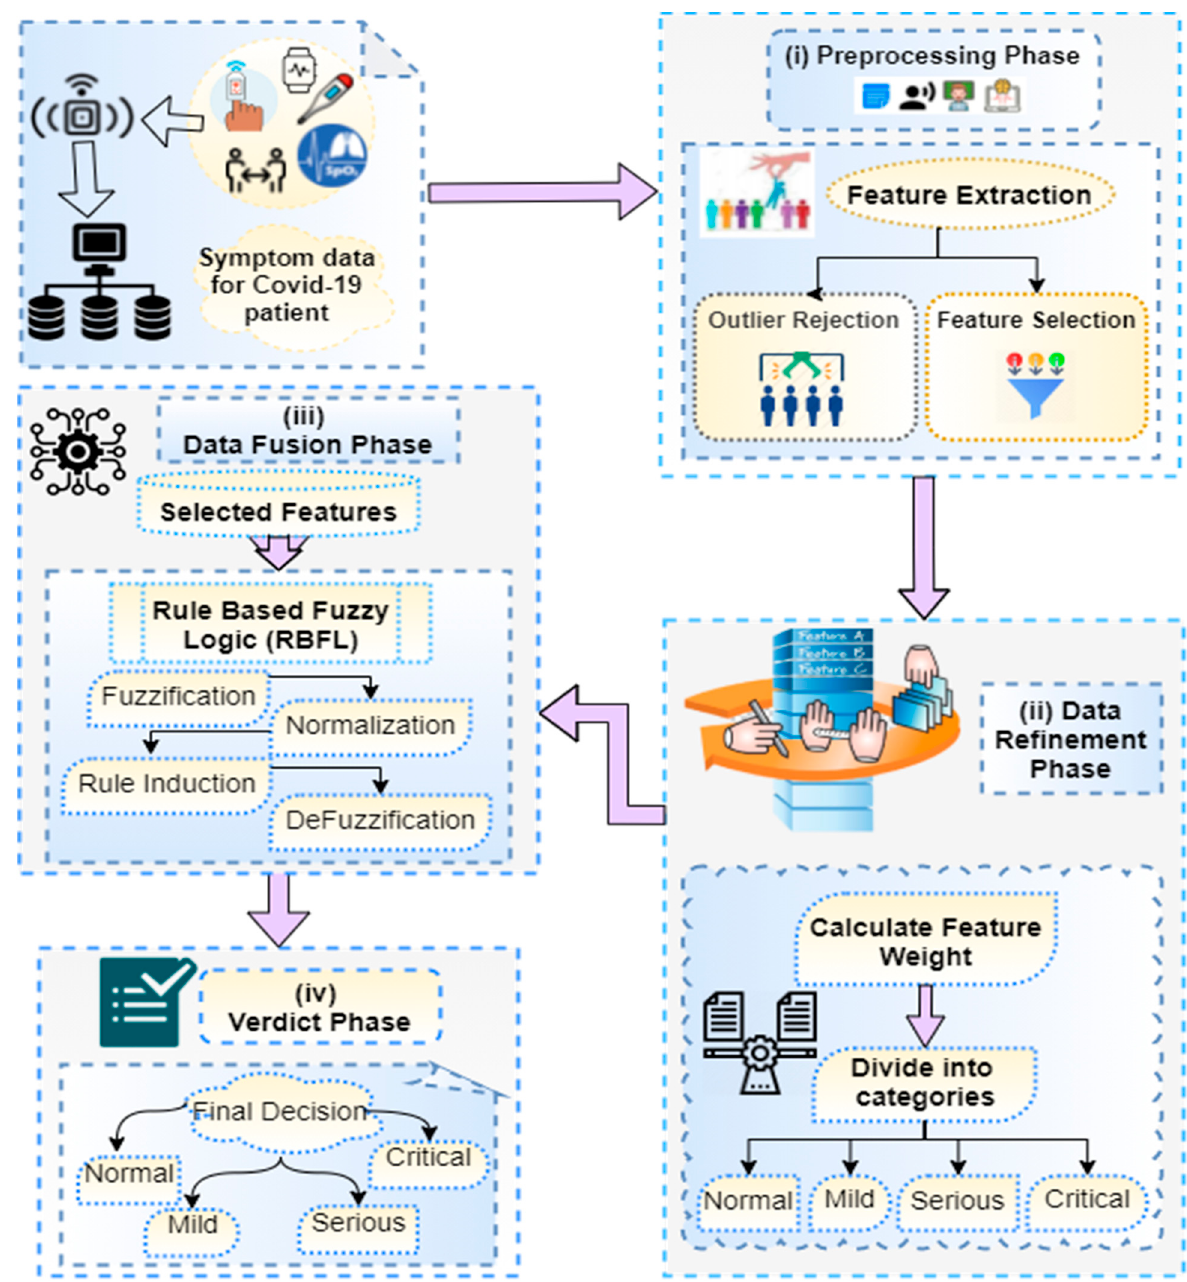
Figure 4. The data fusion layer; ( i ) Preprocessing Phase, ( ii ) Data Refinement Phase, ( iii ) Data Fusion Phase, and ( iv ) Verdict Phase.